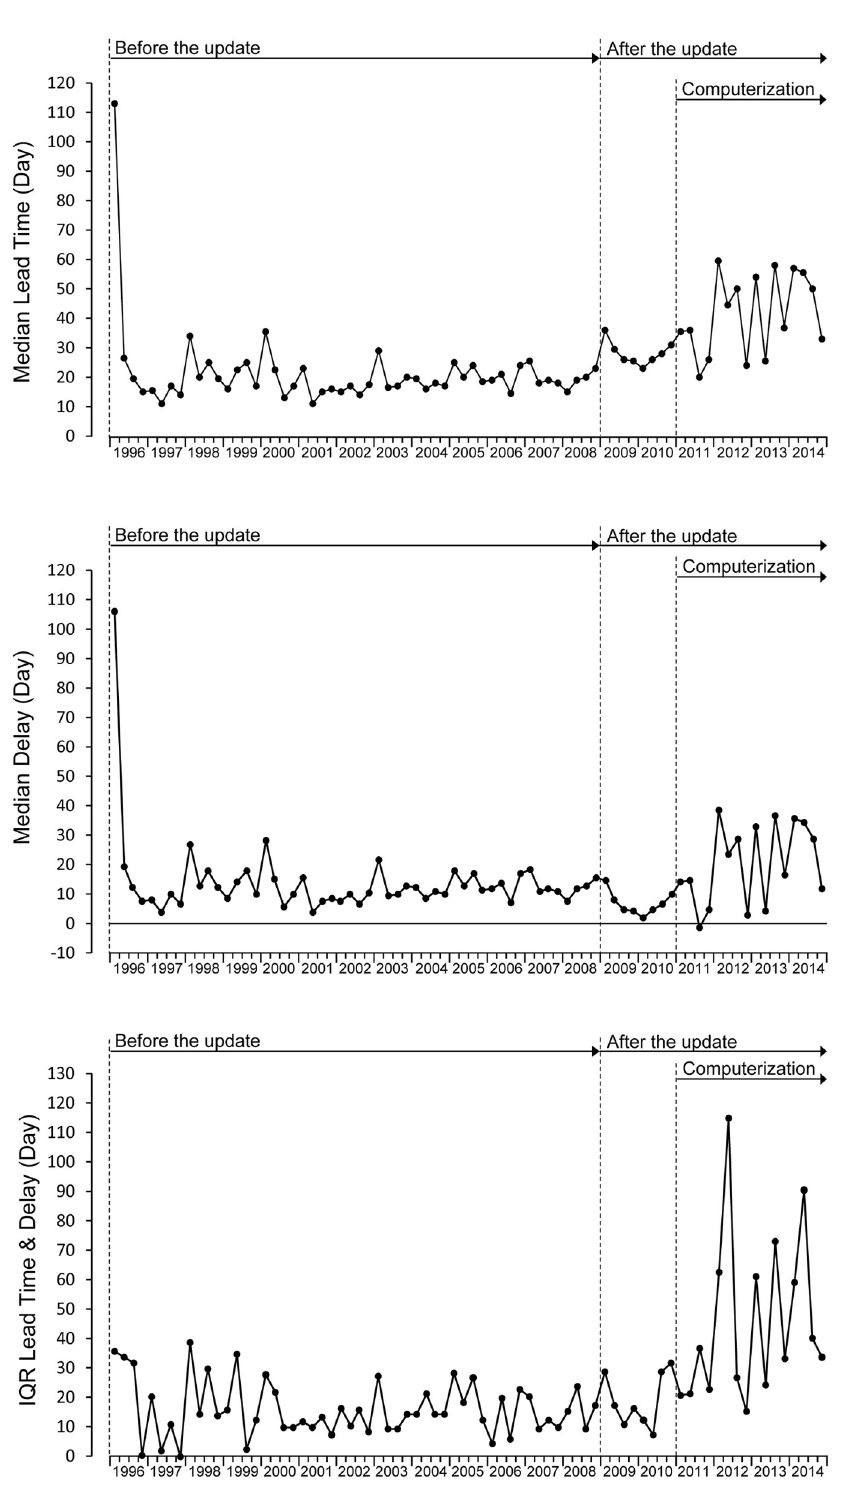
Fig 3. Changes in quarterly median lead time, quarterly median delay, and quarterly IQR. The upper row shows the quarterly changes in median lead time (days). The middle row shows the quarterly changes in median delay (days). The bottom row shows the quarterly changes in interquartile range